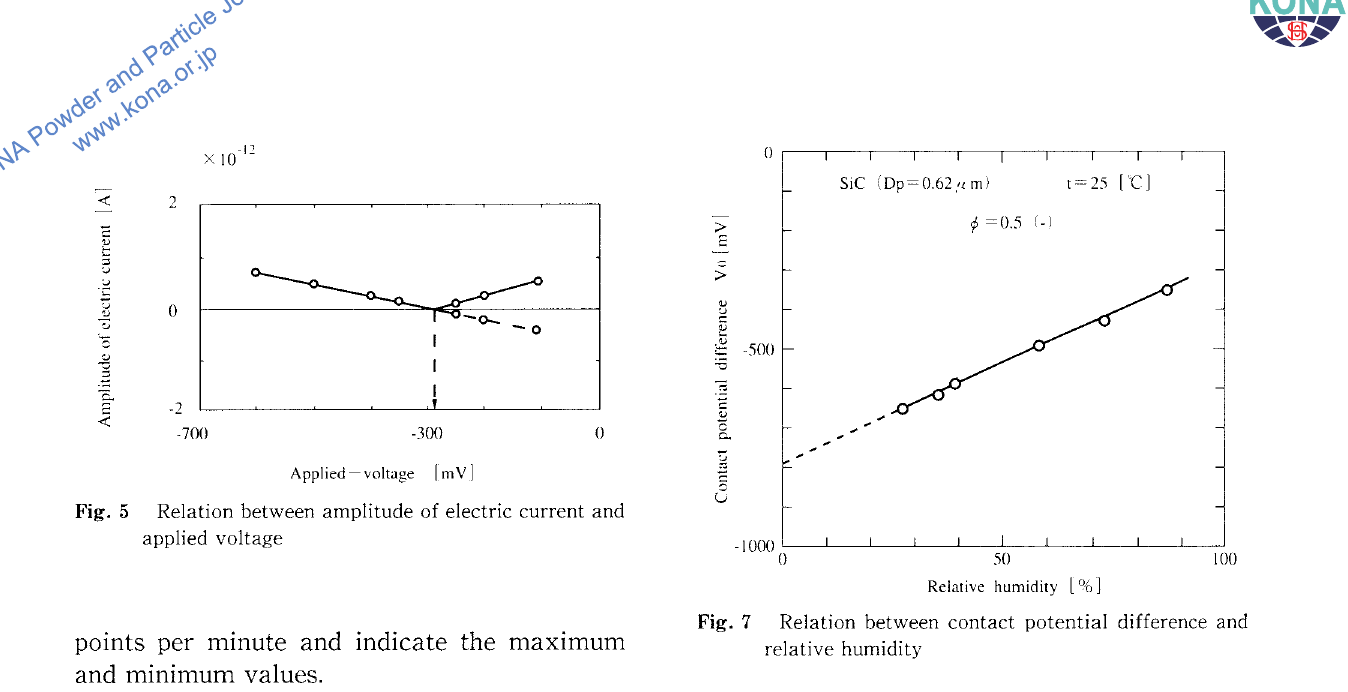
Fig. 7 Relation between contact potential difference and relative